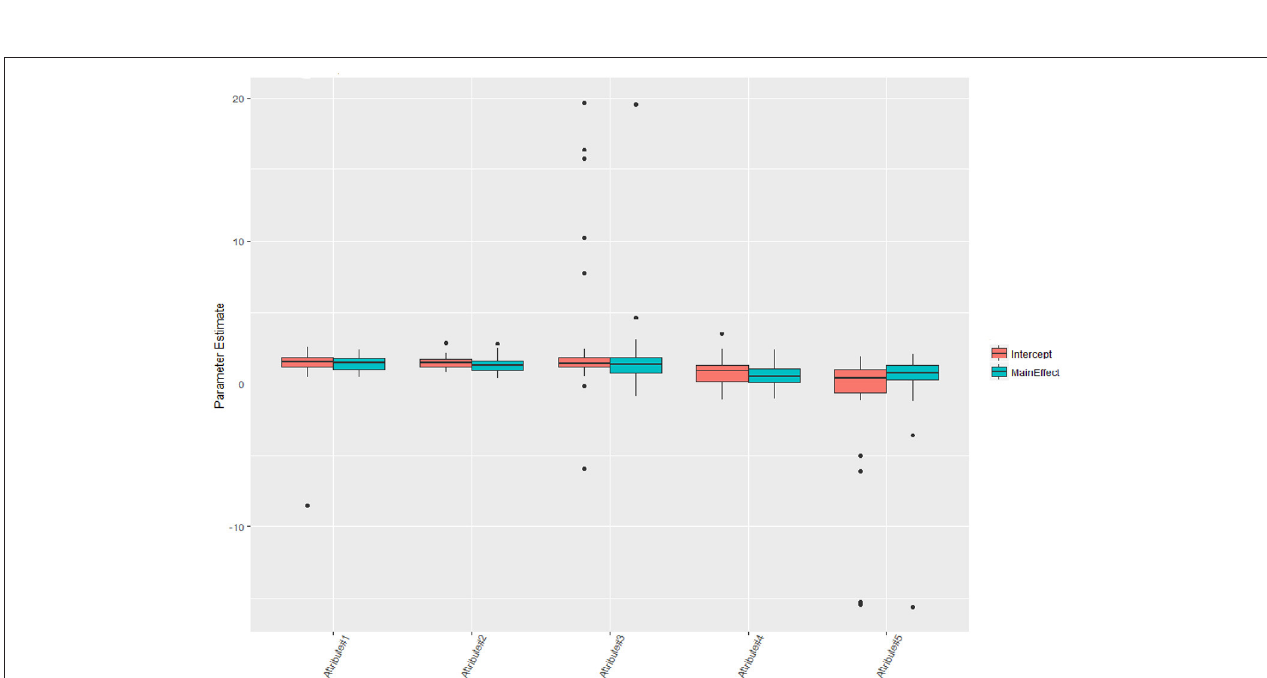
FIGURE 4 | Item parameter estimates of the health profession